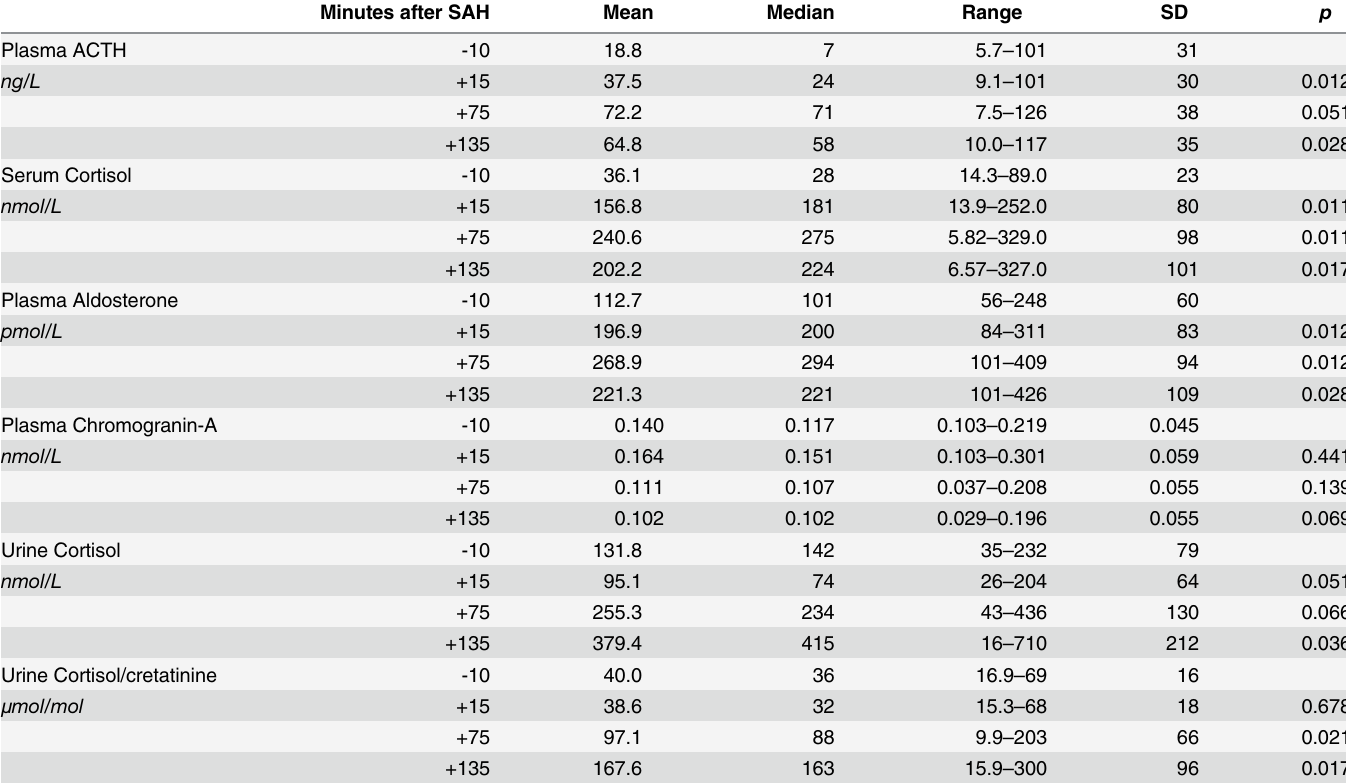
Table 1. Hormone concentration in the animals with transient ischemia (n = 9) and significance testing of change from baseline (-10 minutes) using Wilcoxon matched pairs